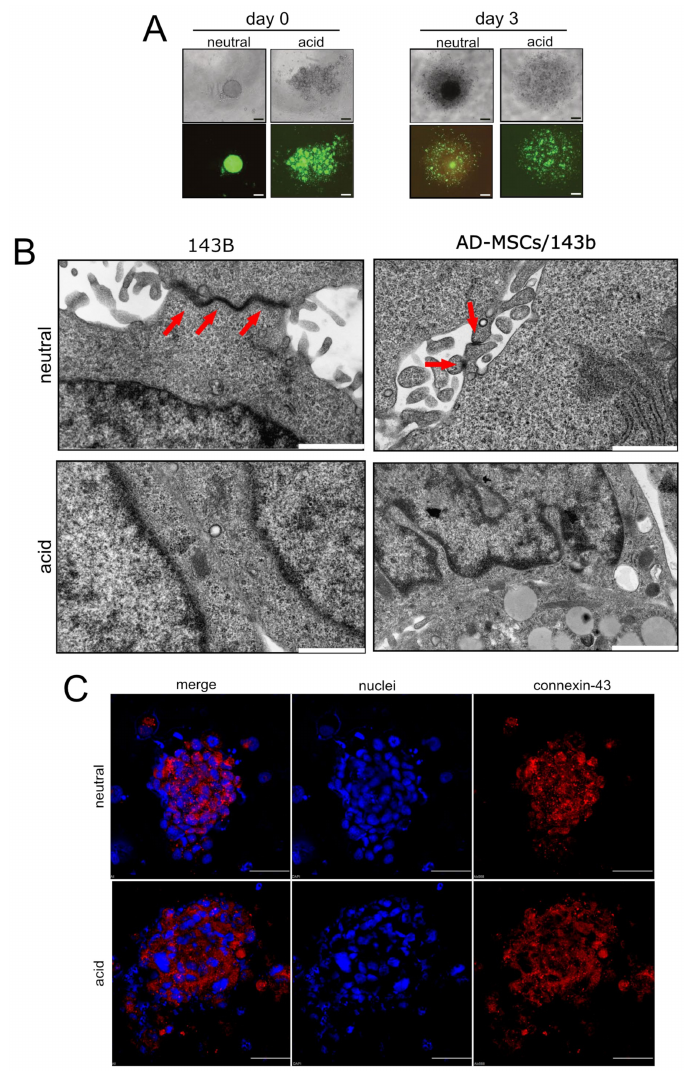
Figure 4. Extracellular acidosis favours the escape of tumour cells in mixed MSC/tumour spheroids. ( A ) Representative images of hanging-drop heterotypic spheroids (luc-143B + GFP-AD-MSC) cultured under neutral or unbuffered conditions (scale bar 50 µ m); ( B ) Transmission electron microscopy images of homotypic spheroids (only 143B cells) or mixed spheroids (AD-MSC/143B cells) cultured at different pH conditions. Representative images. Gap junctions that were clearly visible at pH 7.4 completely disappeared at acidic pH (scale bar 2 µ m); ( C ) Immunofluorescence staining of the gap junction protein connexin-43 in cytocentrifuged and fixed mixed spheroids (AD-MSC/143B cells). Representative images. The expression of connexin43 appeared reduced and more dispersed in acidic conditions with respect to neutral conditions (scale bare 50 µ